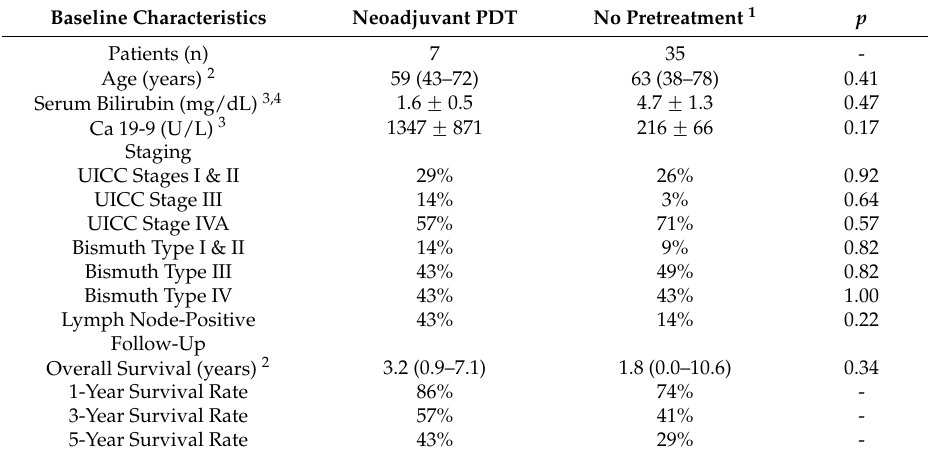
Table 3. Comparison with data on non-pretreated R0 resections of a historical